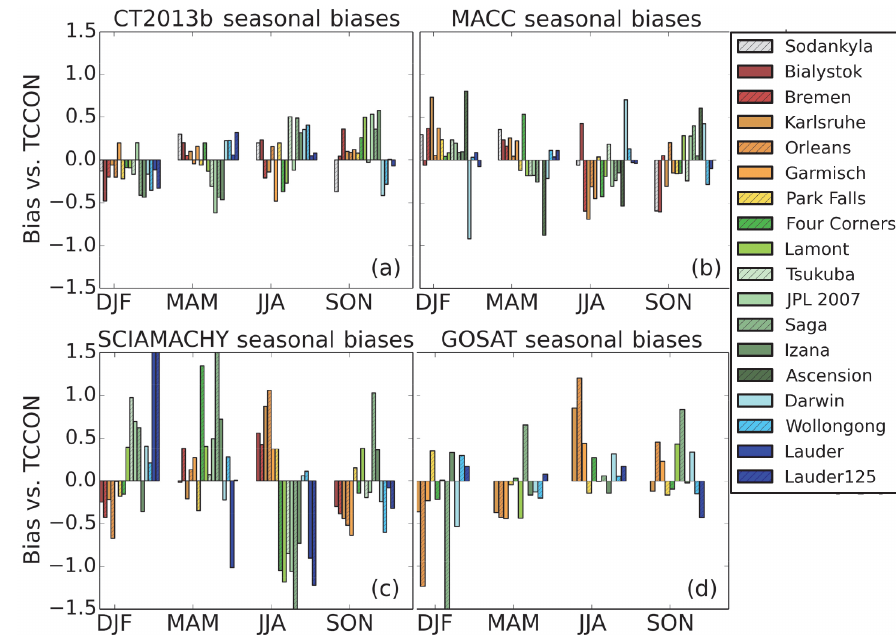
Figure 7. Bias for 3-month groups for each station, where each station is normalized to have 0 yearly bias. For satellites, stations are included when at least 20 matches are found in each season. Dynamic coincidence criteria are used. The station colors are coded by location: far NH gray, European and Park Falls red/yellow, midlatitude green, SH blue.